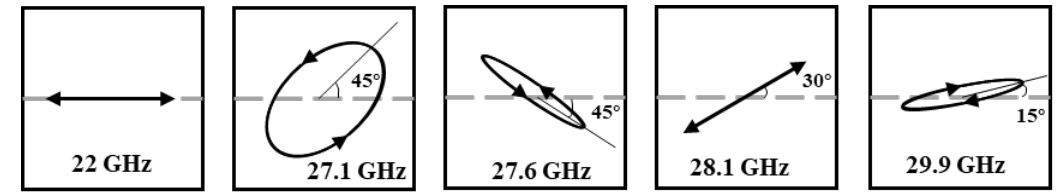
Figure 4. Several polarization states of transmitted wave with y-polarized incidence.